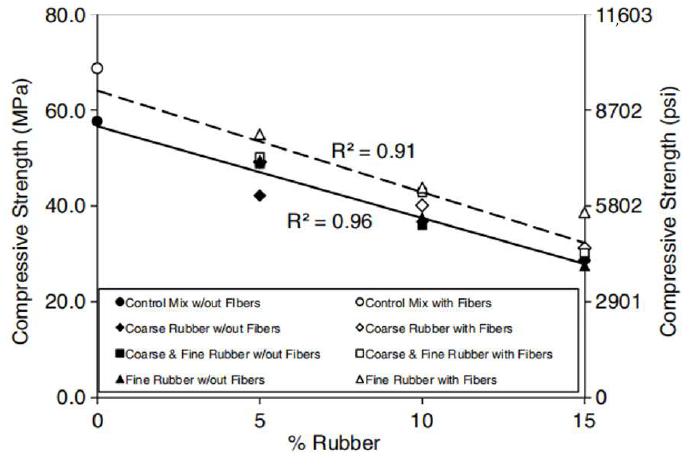
Figure 22. Variation diagram of compressive strength of rubber concrete at 28 days with rubber content